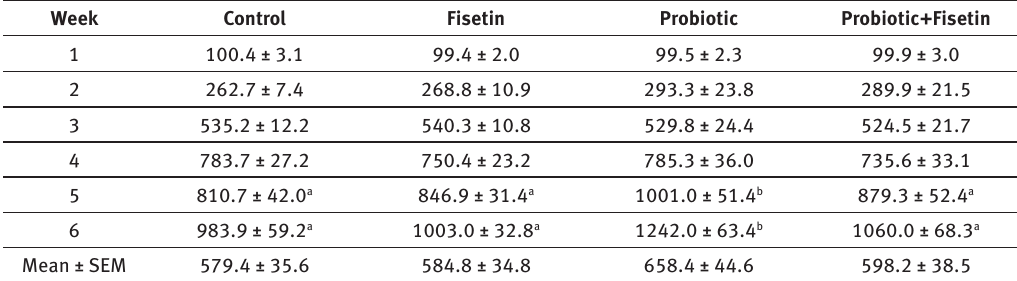
Table 4 Effects of probiotic and/or fisetin on the body weight gain (g) of broiler chickens